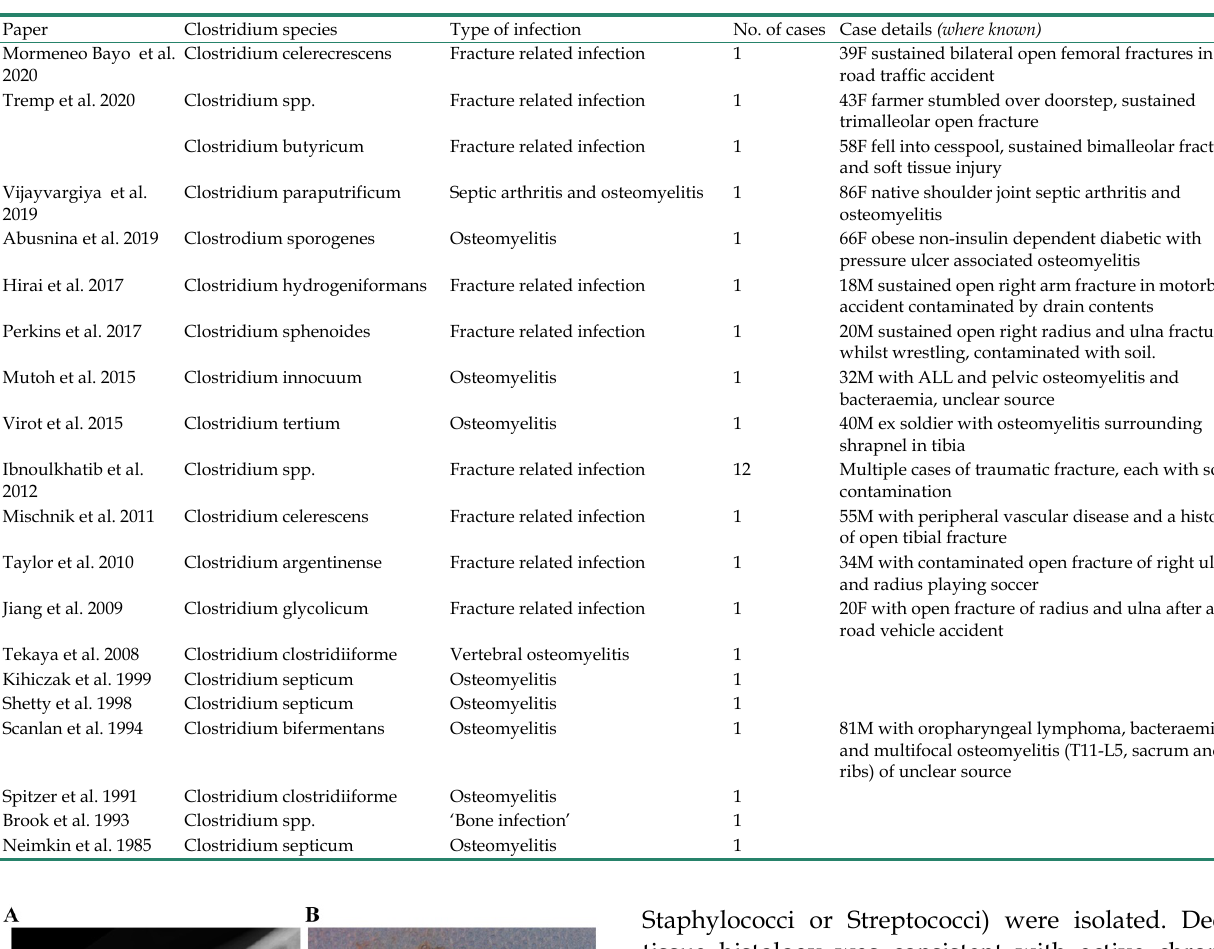
Table 1. A summary of published cases of Clostridial osteomyelitis Paper